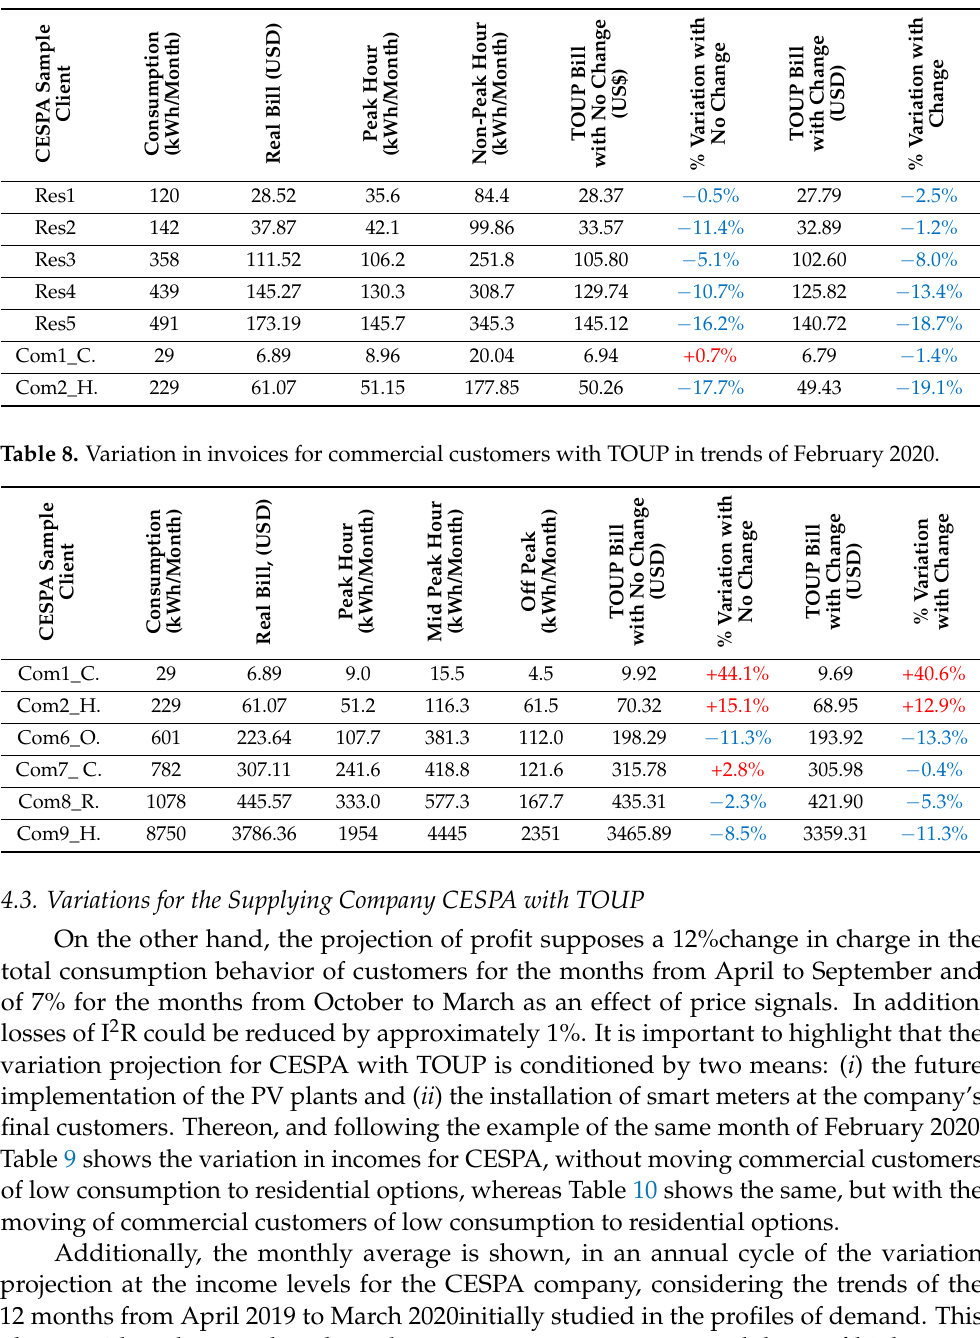
Table 7. Variation in bills for residential customers with TOUP in February 2020 trends.